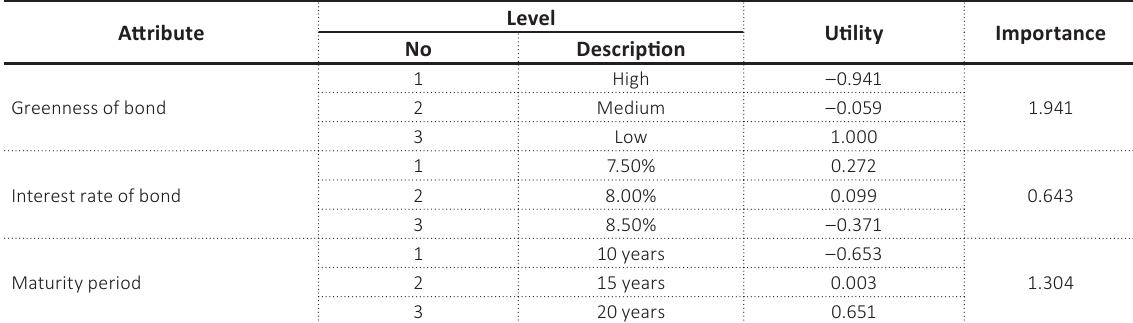
Table 7. Output of the conjoint